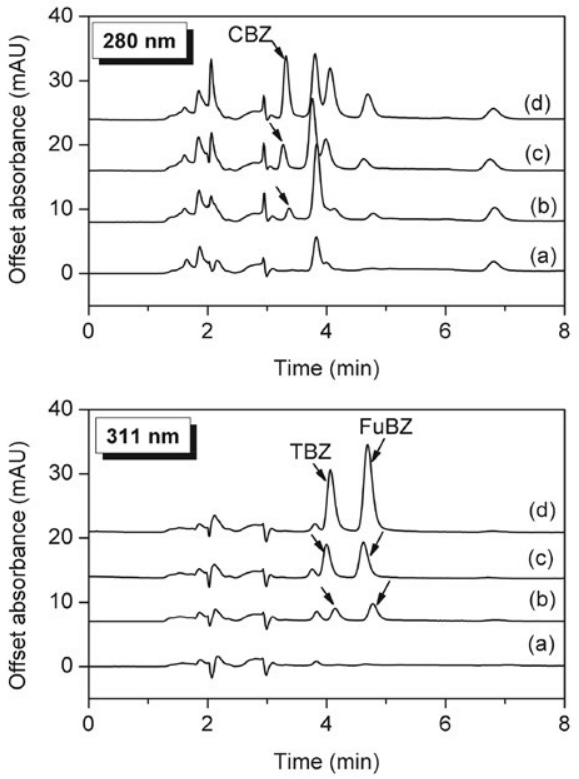
Figure 3: Overlaid chromatograms of honey samples (Brand#1) with (a) honey sample blank and (b–d) spiked at various